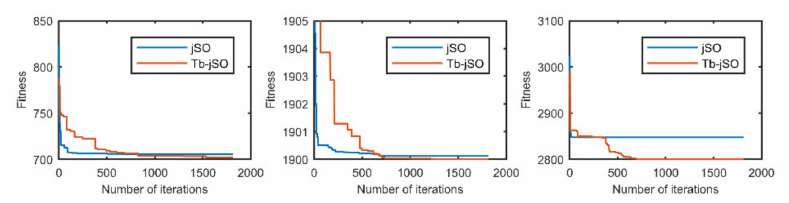
Figure 9. The selected average convergence of jSO and Tb-jSO is compared on CEC2020 in 5 D . From left to right f3, f4 and f10.